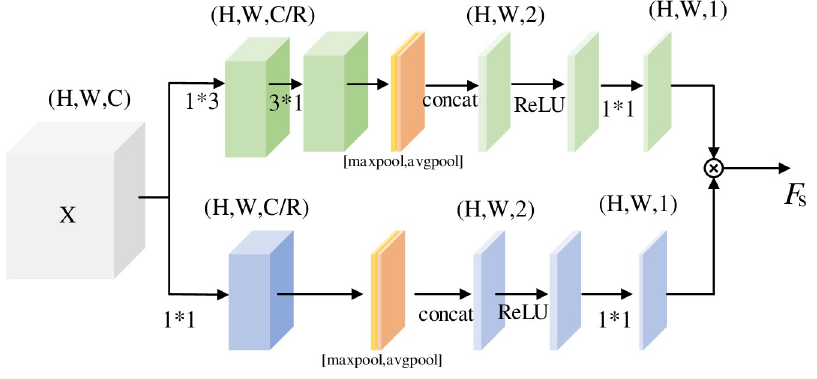
Fig 6. Spatial attention